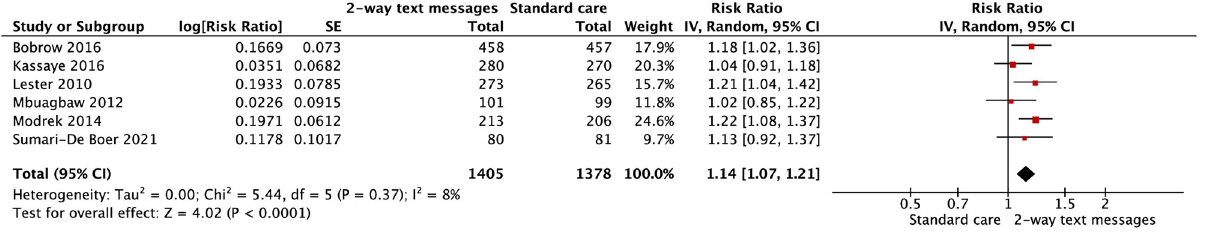
Fig 5. Effect of two-way text messages versus standard care on medicine